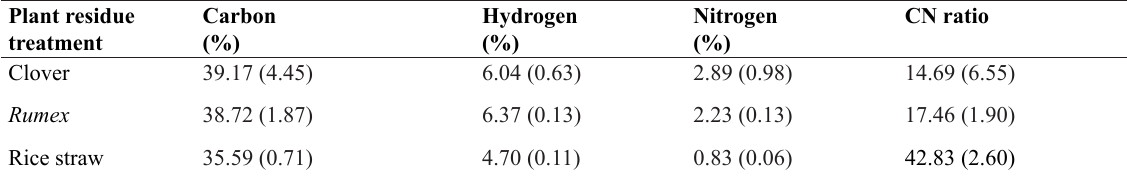
Table 1 The properties of weed and rice-straw residues Plant